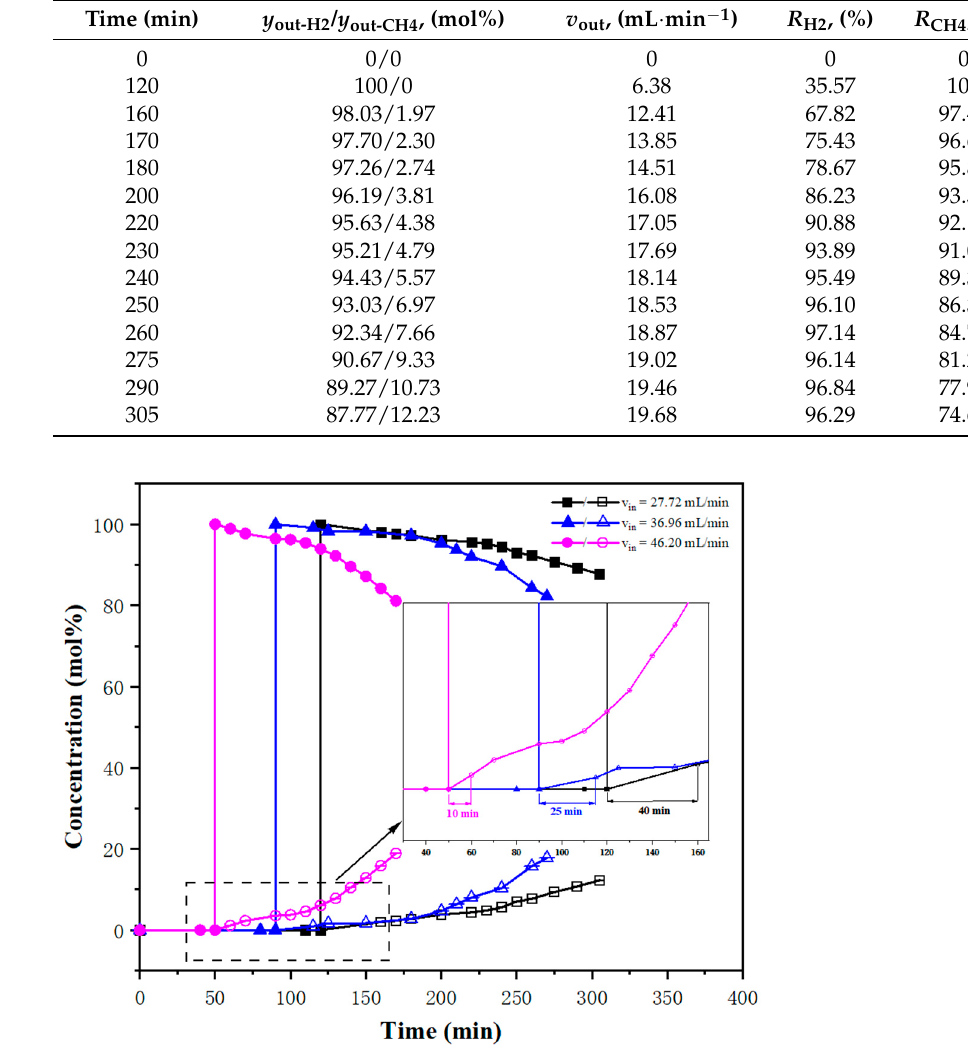
Figure 7. Breakthrough experimental results of the CH 4 /H 2 (34.22/65.78 mol%) mixture separation in a slurry of ZIF-8 20 wt% + ethylene glycol 16 wt% + water 64 wt%, at 273.15 K, 2.0 MPa, and different inlet flow rates of 27.72 mL/min, 36.96 mL/min, and 46.20 mL/min. (The solid curve in the figure is H 2 and the hollow curve is CH 4 ).